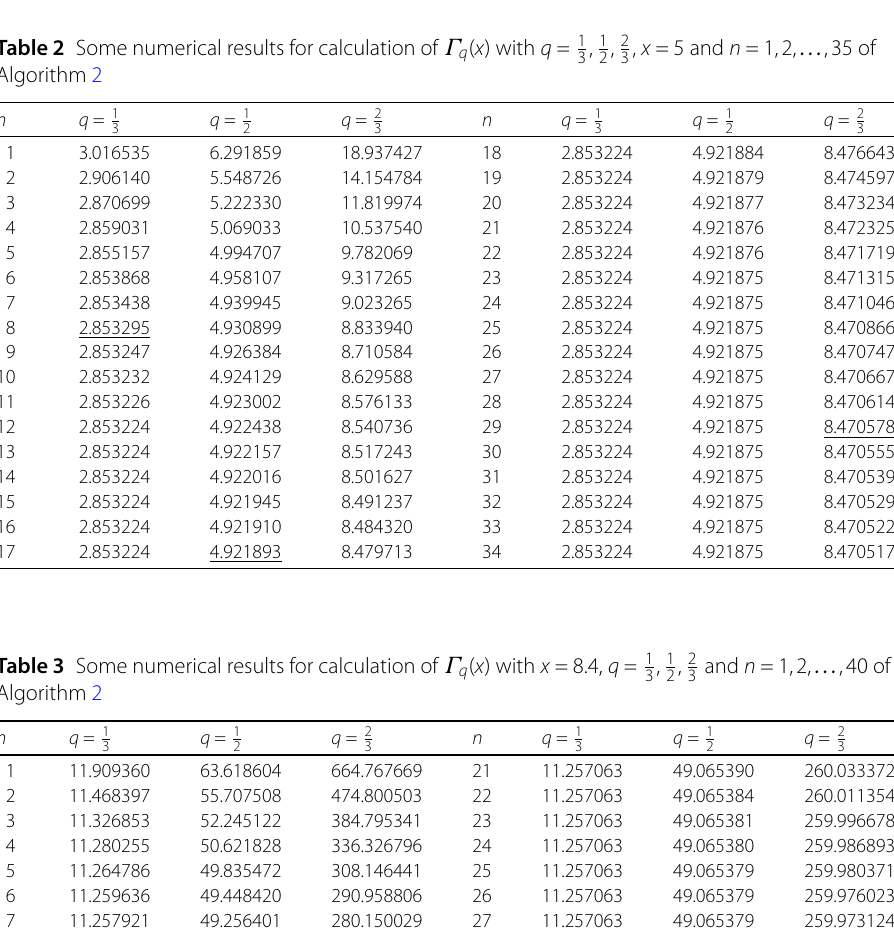
Table 2 Some numerical results for calculation of Γ q ( x ) with q = 1